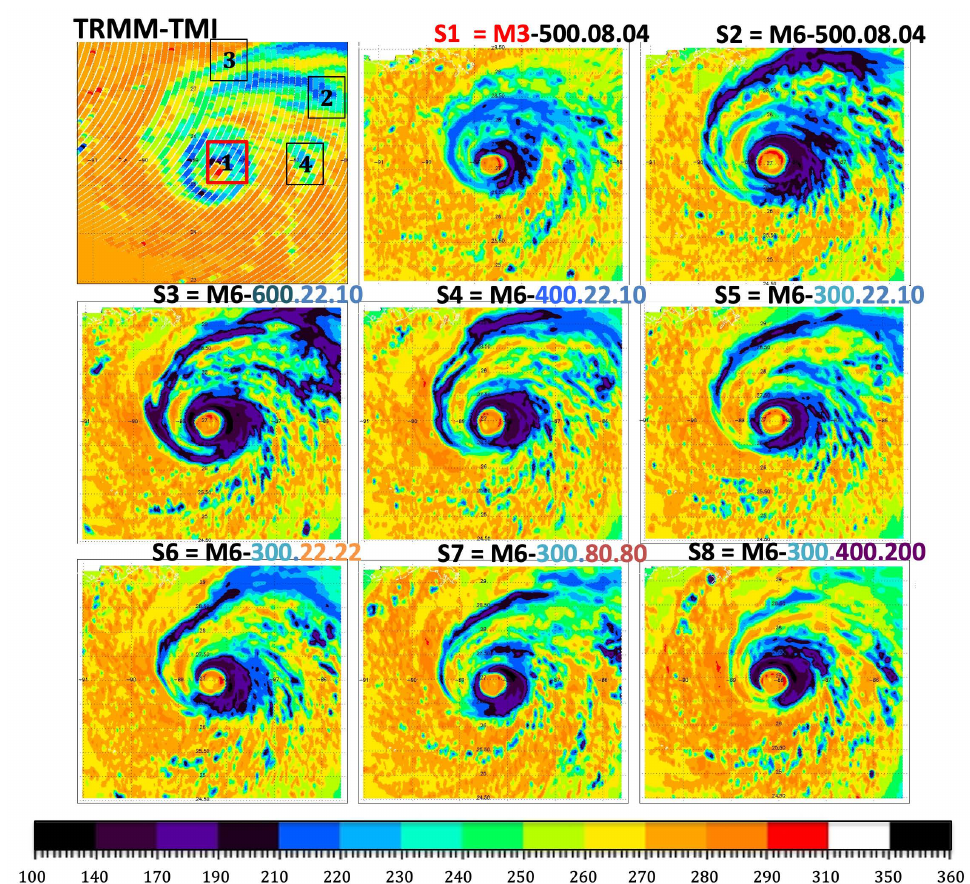
Figure 8. As in Figure 7 except compared are the 85 GHz H-pol brightness temperatures. The 85-GHz signatures are dominated by the scattering from solid hydrometeors out of the beam, producing a depression in the brightness temperature, a cooling signal-which becomes essentially a decreasing function of the vertically-integrated precipitating snow and graupel. The TMI observations have four distinct features: a thin ring of deep layer of frozen hydrometeors about the eye wall; two plumes of ice streaking from the region northwest of the eye wall region extending respectively east-northeastward and eastward, the ice deepening to the east; and a third ice-outflow region to the east of the eyewall region. All 8 simulated storms have deeper 85-GHz depressions than the TMI observations (colder 85 GHz TBs), confirming the widely recognized fact that single-moment